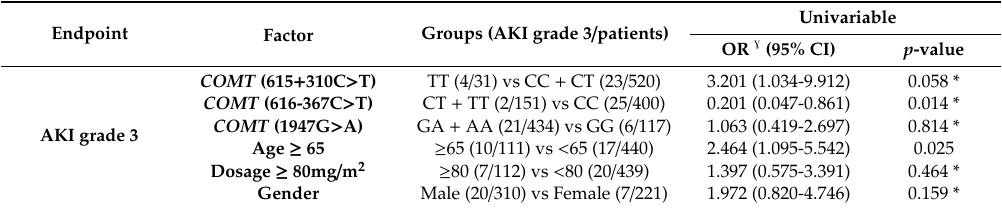
Table 4. Associations of AKI grade 3 with SNPs and confounders and the number of AKI grade 3 per patient